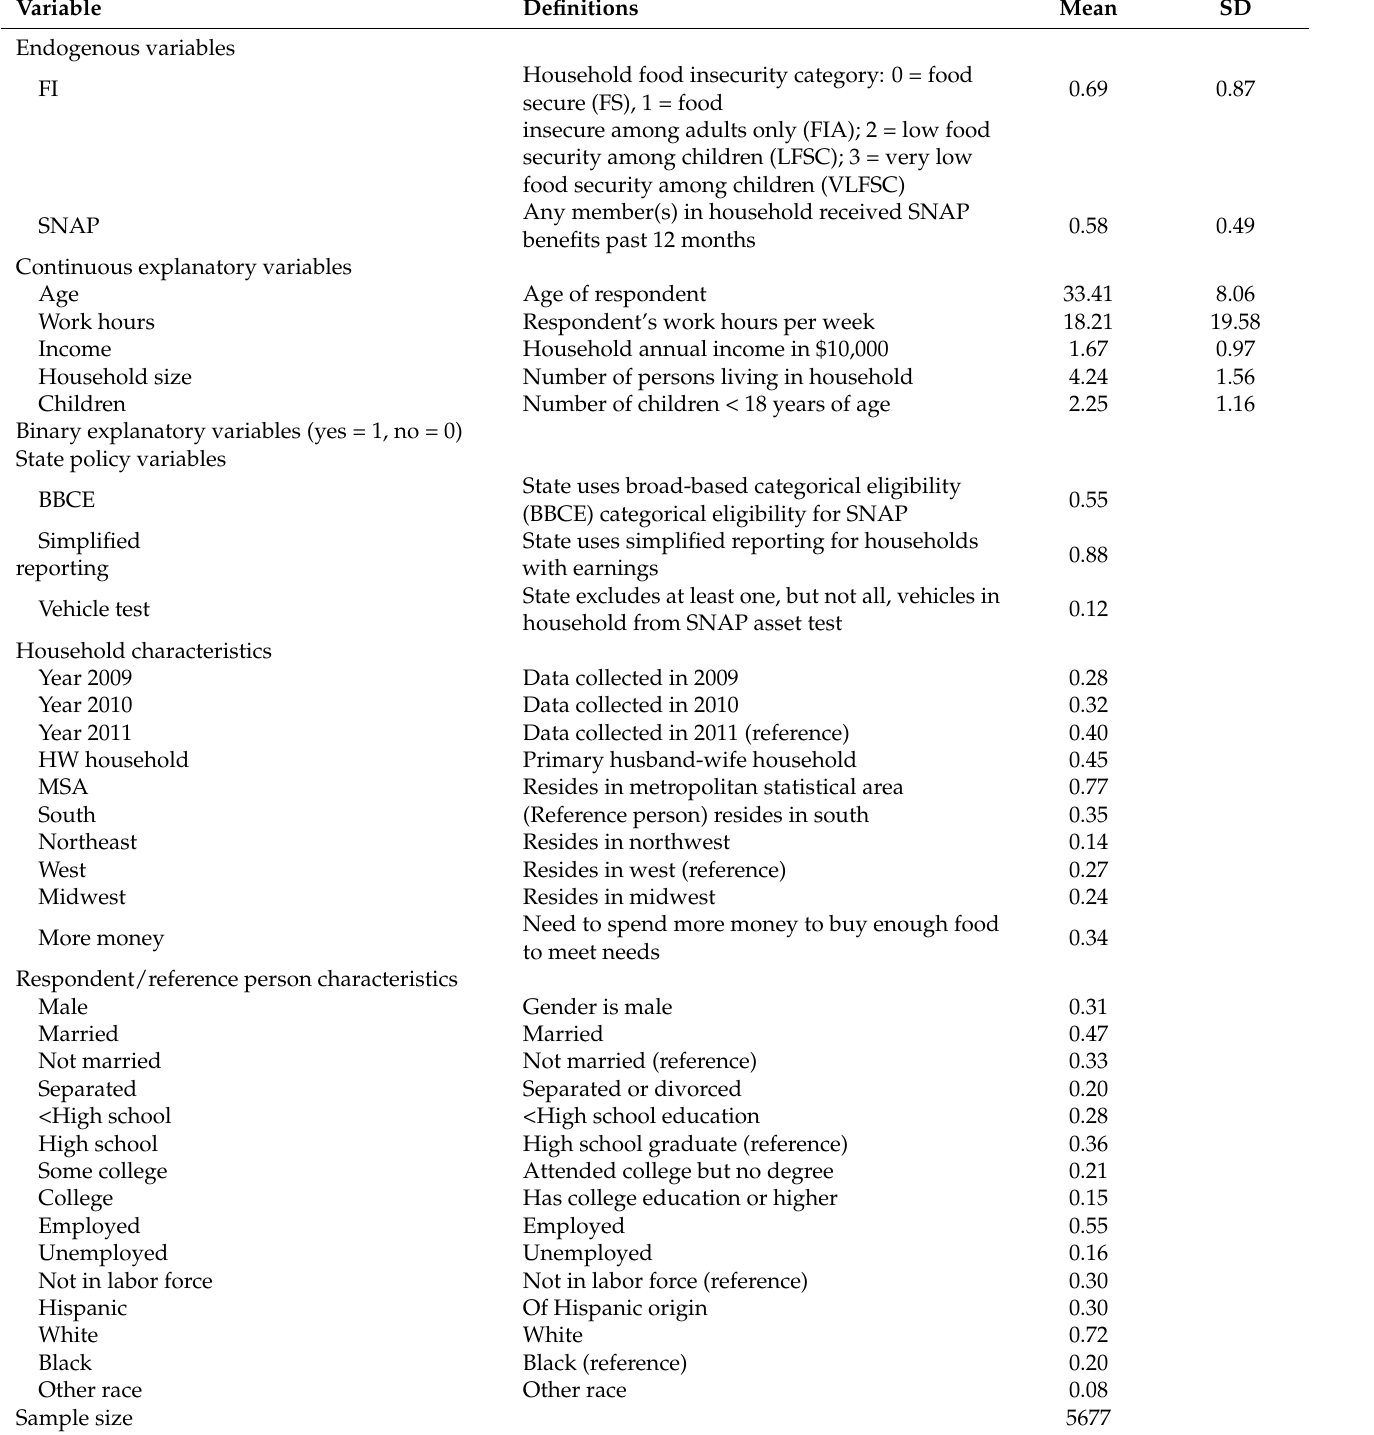
Table 1. Definitions and sample statistics of